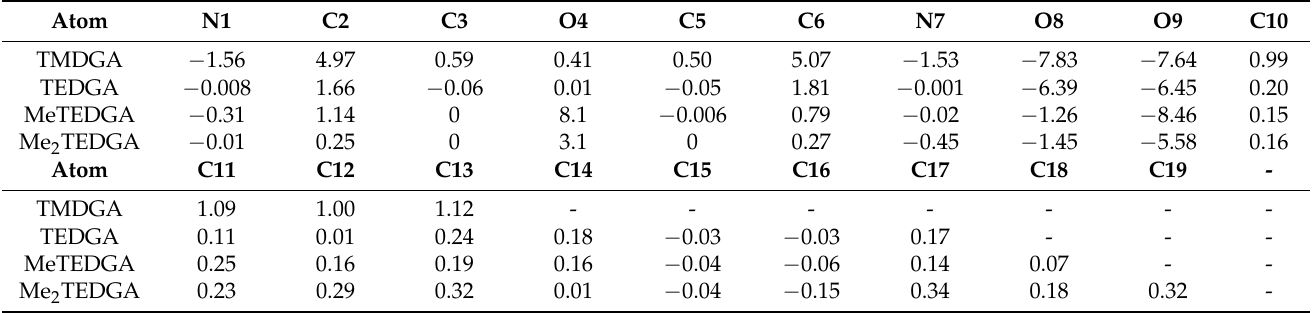
Table 1. CDD × SASA k values × 10 − 3 obtained for each non-hydrogen atom in the DGAs